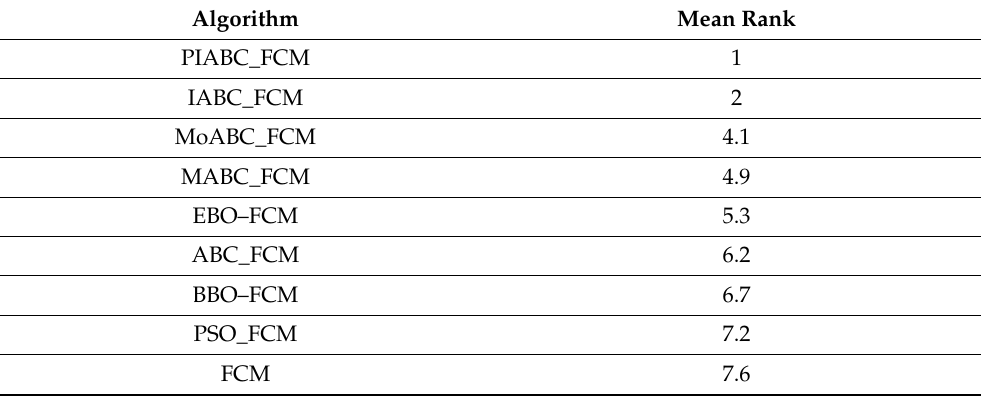
Table 7. Friedman Test based on CE validity index—result for natural images.